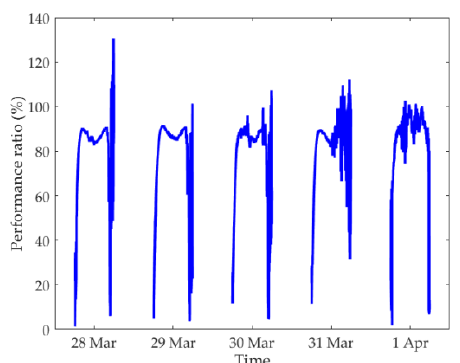
Figure 2. Instantaneous PR from 28 March to 1 April 2015.